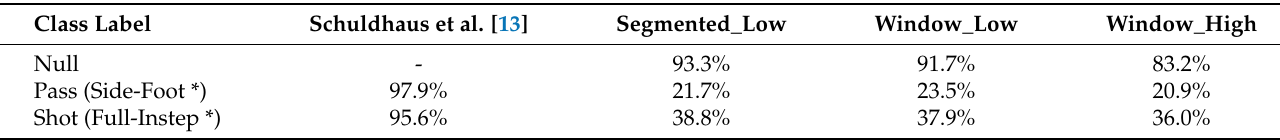
Table 9. Comparison of the classification result from Schuldhaus et al. [13] and our own evaluation approaches seg- mented_lab, window_lab and window_field for the SVM classifier. Schuldhaus et al. [13] classified full-instep versus side-foot kicks (marked with *) on segmented laboratory data, whereas our approaches classify shots and passes in general. In segmented_lab , segmented events extracted from lab data are used for evaluation. window_lab and window_field apply moving windows, peak detection for candidate selection and classification to laboratory and field data, respectively. In accordance with Schuldhaus et al. [13] we reported the class specific sensitivity scores.